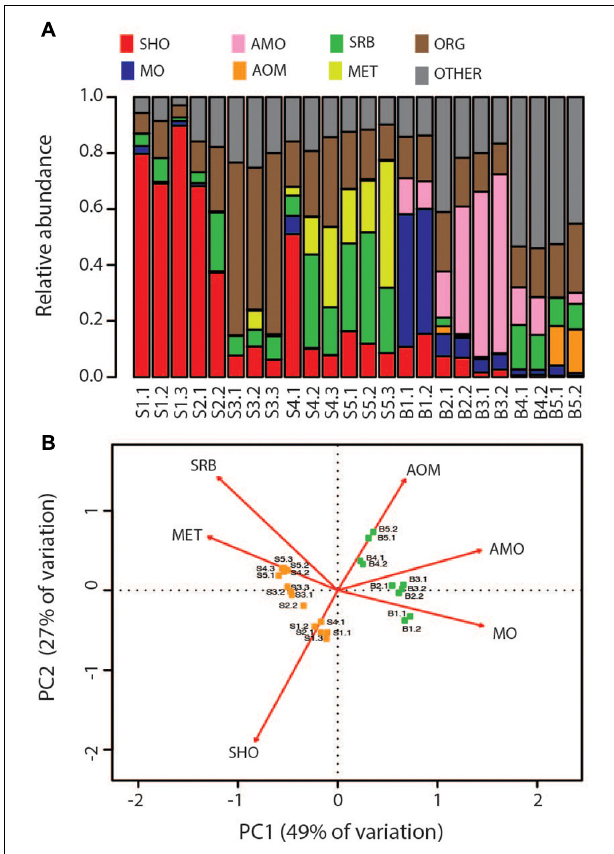
FIGURE 5 | Comparison of the Bruse chimney and Soria Moria chimney in terms of the functional groups of microorganisms they host. Functional assignments were performed based on taxonomic information (see Supplementary Material). Abbreviations of functional groups are the same as in Table 2 . (A) Distribution of functional groups in each sample. (B) Ordination diagram in two dimensions from Principal Component Analyses based relative abundances of functional groups after removal of organotrophs and metabolically unassigned organisms. The ordination is drawn as a biplot where samples are represented as dots and functional groups by arrows. Eigenvectors are scaled to unit length and distances among objects and the biplot are approximations of their Euclidian distance in multidimensional space. Arrows point in the direction of maximum variance of relative abundance of respective functional groups. Arrow lengths correspond to the contribution to variation in community composition between samples. Sample names correspond to the short names given in Table 1